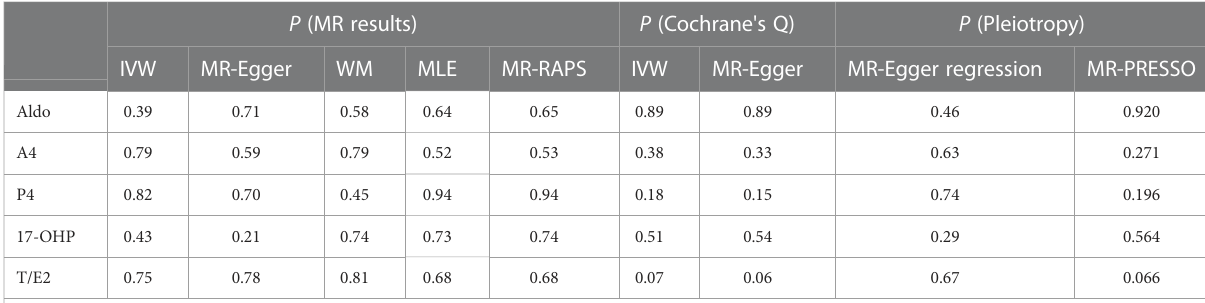
TABLE 4 MR results and sensitivity analyses between steroid hormones and AMD in the discovery